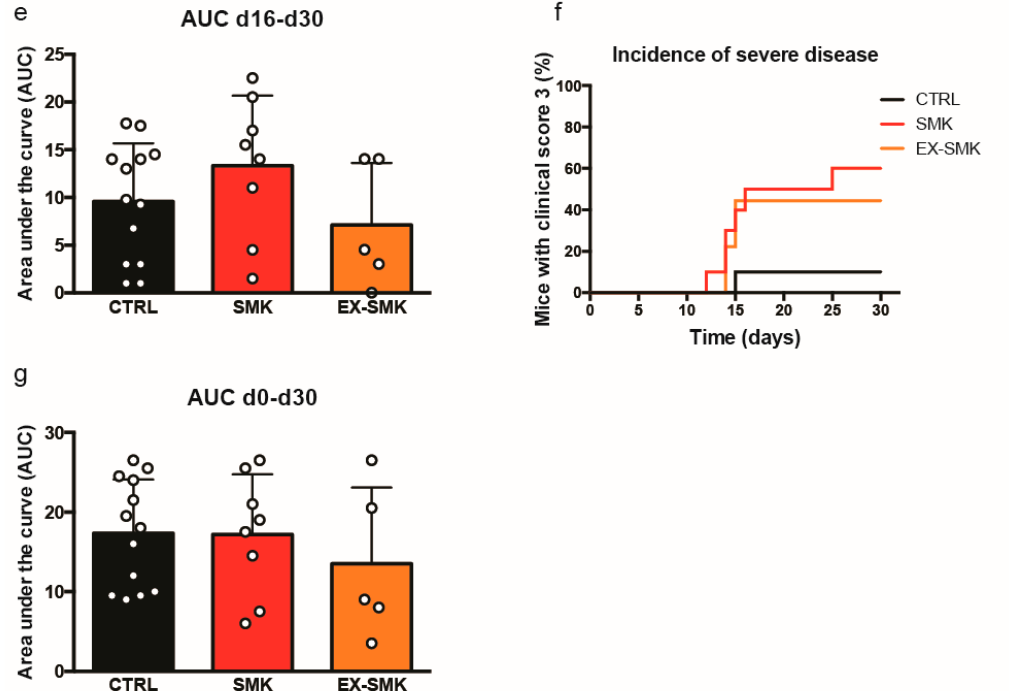
Figure 4. Cigarette smoke exposure delays active EAE onset and remission in SJL mice. Groups of SJL/J females were exposed to room air or cigarette smoke as shown in Figure 3. Clinical score ( a ), body weight ( b ) and disease onset ( c ) are shown for SJL/J mice immunized with PLP ( n = 9–10 mice/group). Overall disease severity of mice from experiment 1 and experiment 2 was compared by calculating the area under the curve (AUC) between day 0–15 pI ( d ) ( p < 0.05, unpaired t-test), 16–30 pI ( e ), and for the whole duration of the experiment day 0–30 ( g ) ( n = 23 mice/group). ( f ) Incidence of severe disease is shown as the fraction of mice with a clinical sore of 3 (experiment 1: n = 9–10/group). Data are shown as mean ± SEM ( a – g ) and statistical differences between the groups for disease onset and AUCs ( c – e , g ) were analyzed using the t-test (* p <